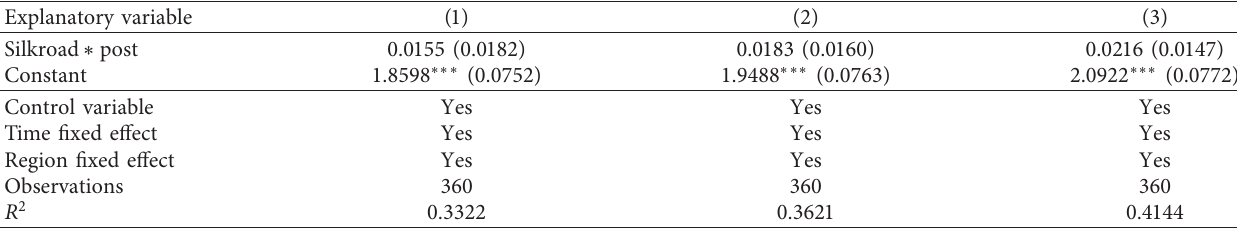
Table 5: Effects of the Belt and Road Initiative on unified efficiency of transportation infrastructure assuming that the Initiative was proposed ahead of time.